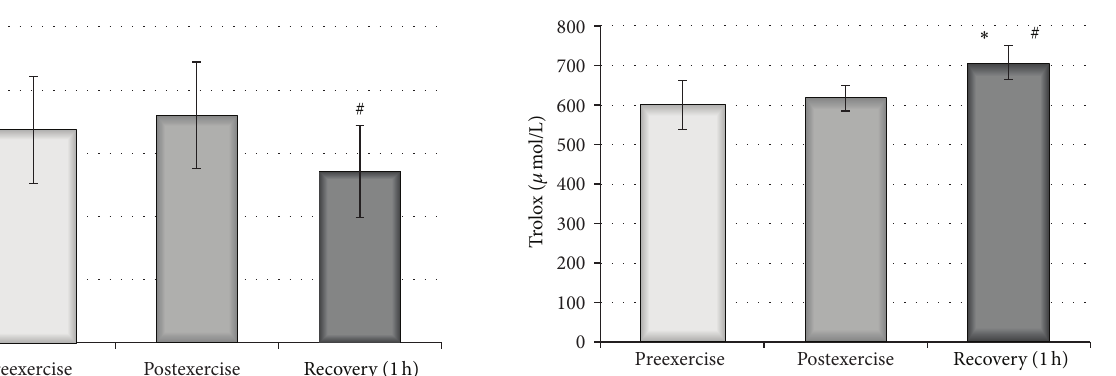
Figure 4: Influence of physical exercise on thiol group concentra- tion of erythrocyte membranes measured before, after, and 1 hour after exercise. # indicates significant difference between postexercise and 1h recovery ( 𝑃 < 0.05 ).